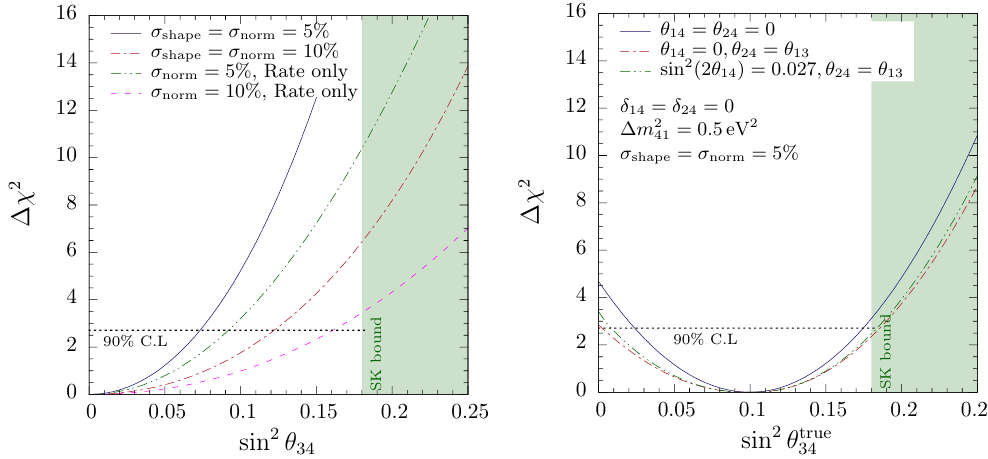
Figure 3 . Left panel: expected sensitivity to (cid:18) 34 under the assumption (cid:18) 14 = (cid:18) 24 = 0. The di(cid:11)erent lines correspond to di(cid:11)erent assumptions of systematical uncertainties, see text for details. Right panel: (cid:18) 34 -discovery reach analysis where 4-(cid:13)avor event rates were calculated in ‘data’ and (cid:12)t, with all the 4-(cid:13)avor parameters (cid:12)xed to the values in the plot, except for (cid:18) 34 . Also, as shown in the plot, we (cid:12)xed the systematical errors to 5%. The shaded region is disfavored at 90% C.L. from Super-Kamiokande atmospheric data [4] and whose limit on j U (cid:28) 4 j 2 < 0 : 15 (at 90% CL) translates into the constraint sin 2 (cid:18) 34 < 0 : 15, for (cid:18) 14 = (cid:18) 24 = 0. The horizontal dotted line indicates the value of the (cid:1) (cid:31) 2 corresponding to 90% C.L. for 1